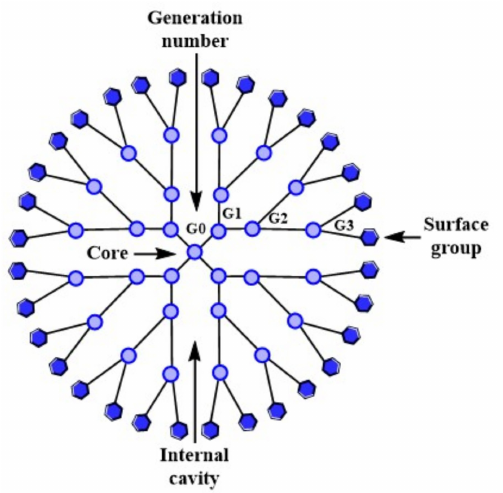
Figure 5. General structure of dendrimers. Adapted from [139], published by Int. J. Nanomed,